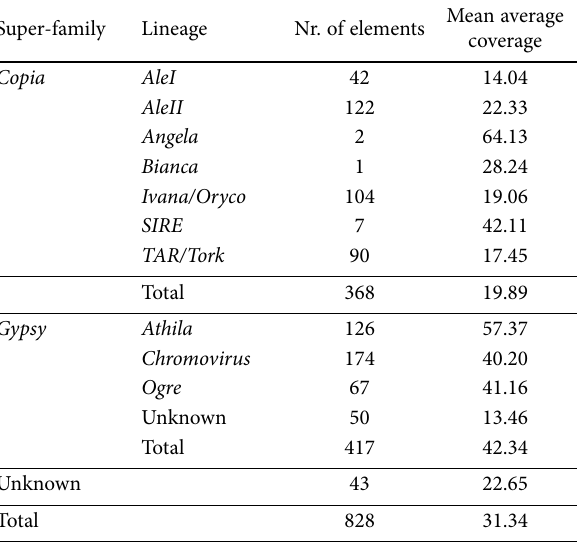
Table 1. Number and mean average coverage of full-length LTR-REs collected in the P. trichocarpa genome (version GCA_000002775.3) and separated according to their superfamily and